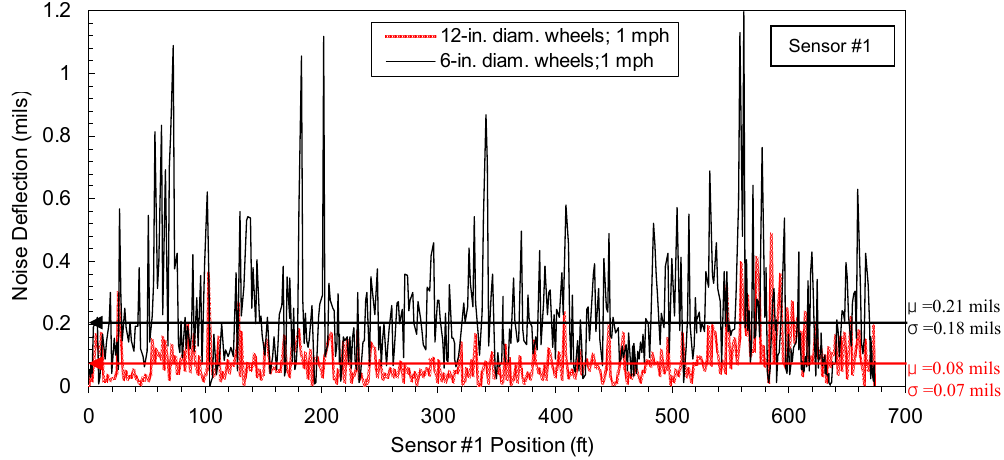
Figure 5. Noise-deflection profiles of the old and new rolling sensors, collected along a jointed concrete pavement at the speed of 1 mph (note: the wheel diameters of the old and new sensors are 6 and 12 in. diameters, respectively). Table 3. Theoretical maximum acceleration with different levels of hold-down. Pressure in air spring.